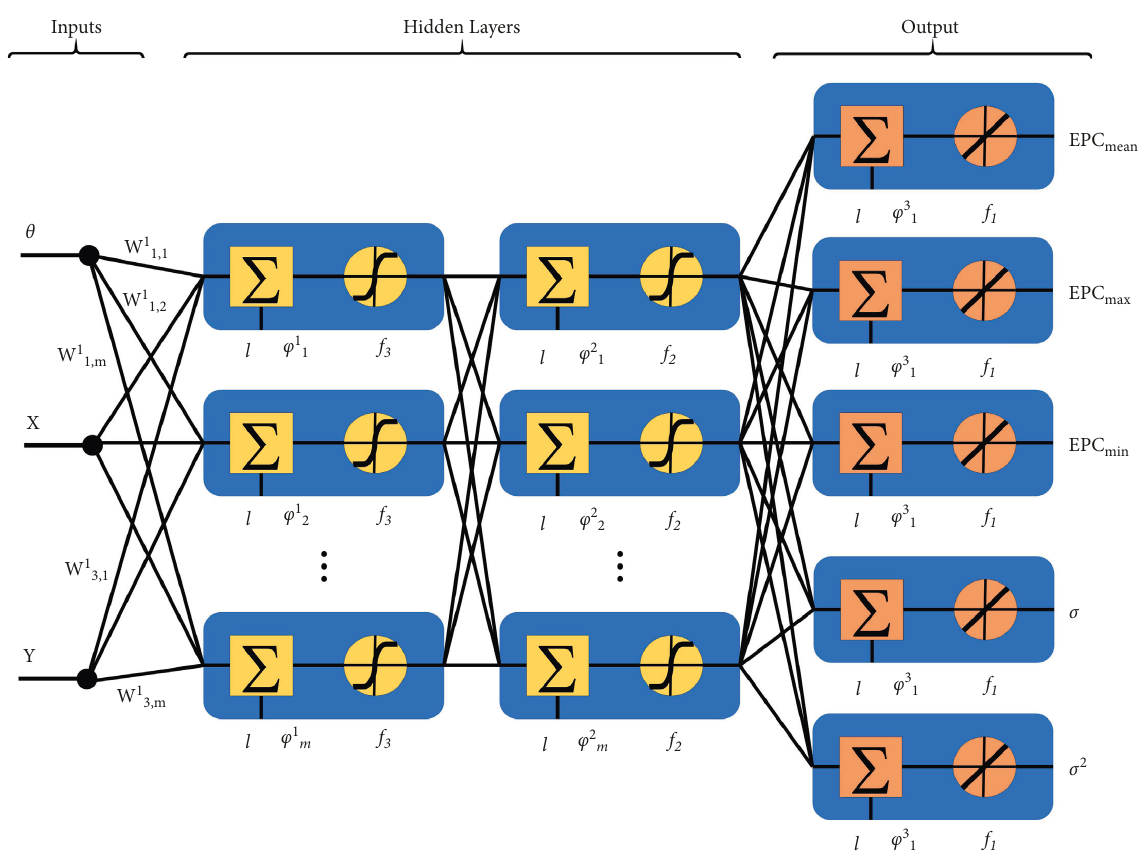
Figure 1: FFNN architecture with two hidden